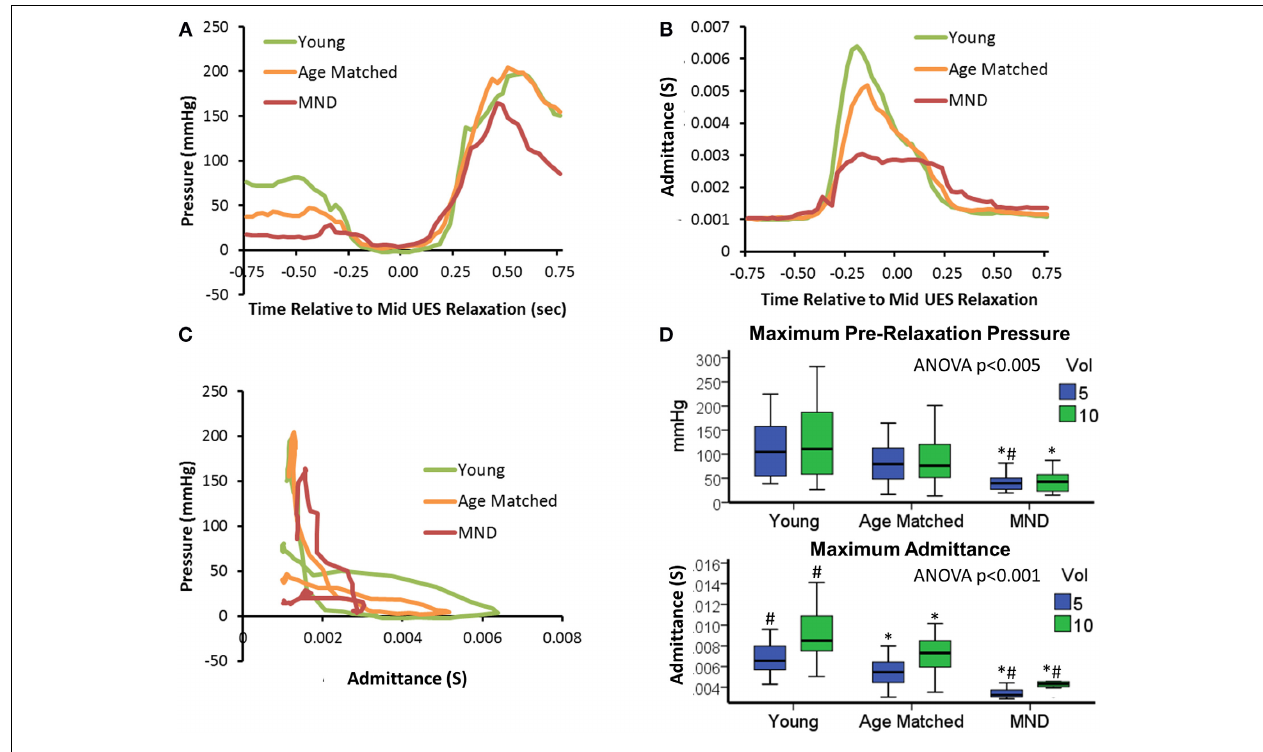
FIGURE 11 | UES pressure-admittance profiles across study groups. (A) Median UES pressure over time for 5ml boluses. (B) Median UES admittance over time for 5ml boluses. (C) Orbit plots based on admittance and pressure for 5ml boluses.